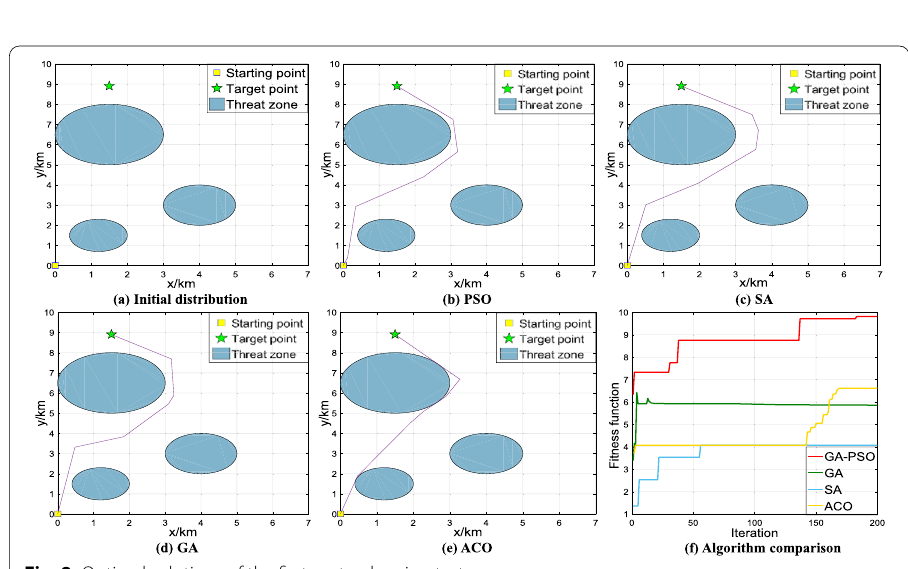
Fig. 8 Optimal solutions of the first route planning